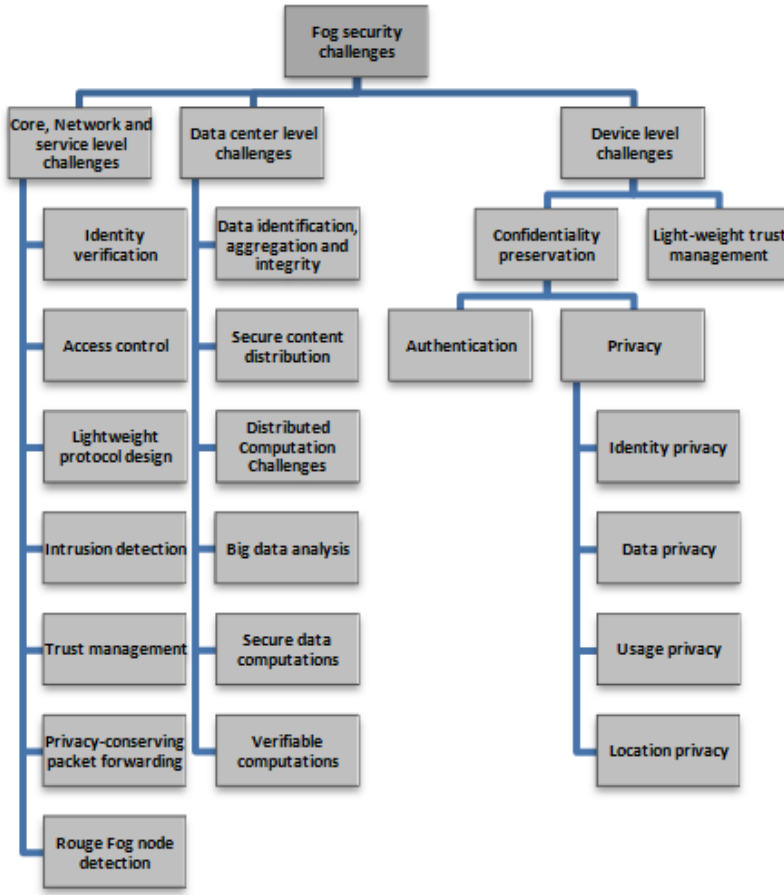
Figure 4. Taxonomy of IoT-based fog security